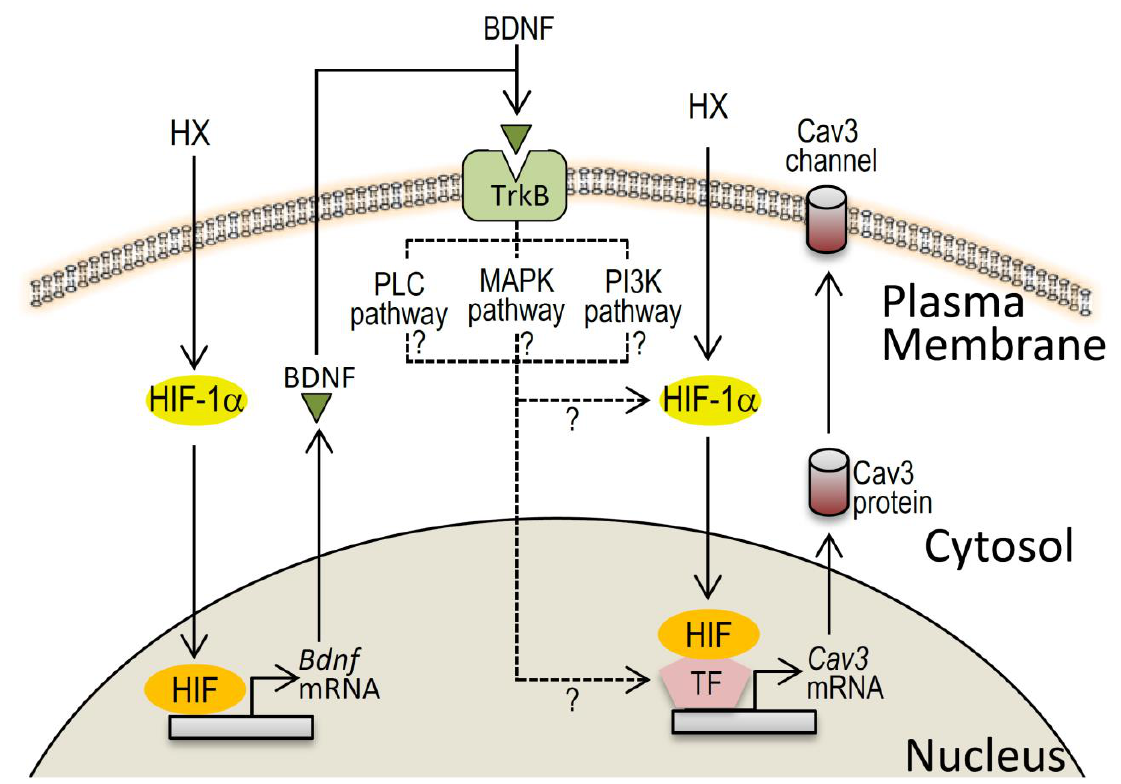
Figure 7. Schematic diagram of hypothetical BDNF-hypoxia interaction in regulation of the Cav3 channels in cardiomyocytes. Hypoxia (HX)/BDNF axis may work as a positive regulator for the Cav3-T-type Ca 2+ channels through the activation of HIF-1 α in cardiomyocytes, although the downstream signals of BDNF/TrkB and the targeted transcription factor(s) (TF) are unknown.